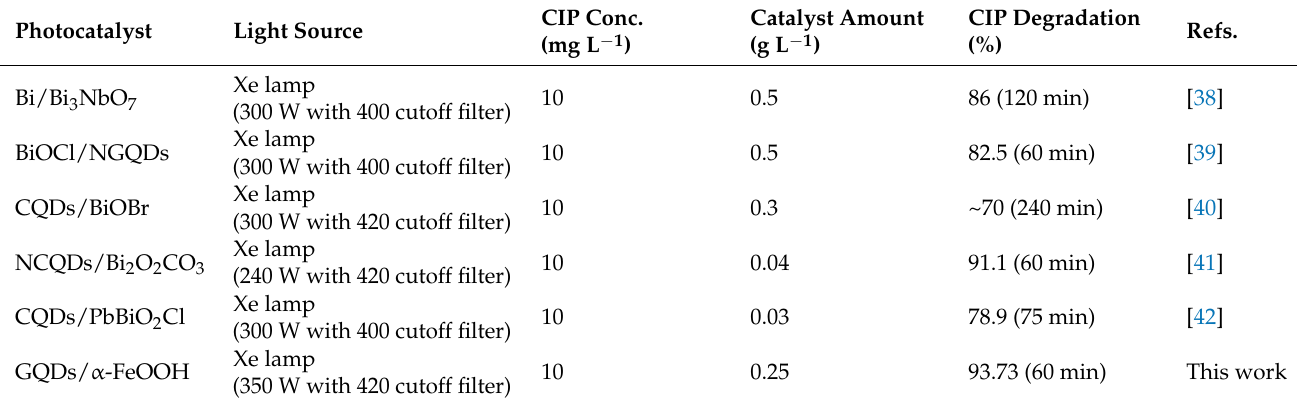
Table 2. Comparison of CIP degradation performance in a photocatalytic